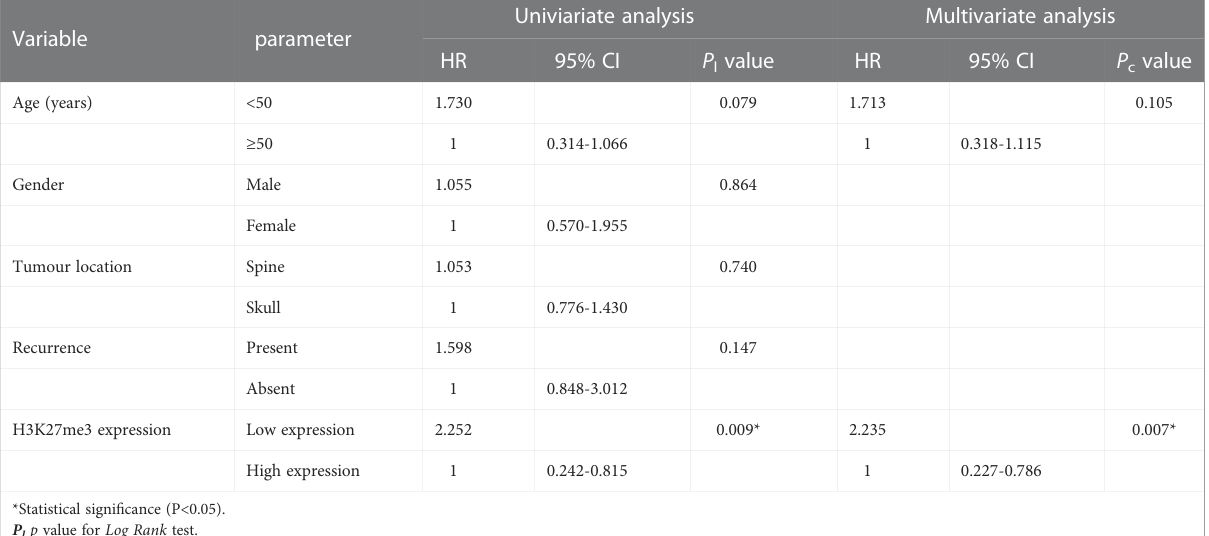
TABLE 2 Univariate and multivariate analysis of overall survival for chordoma